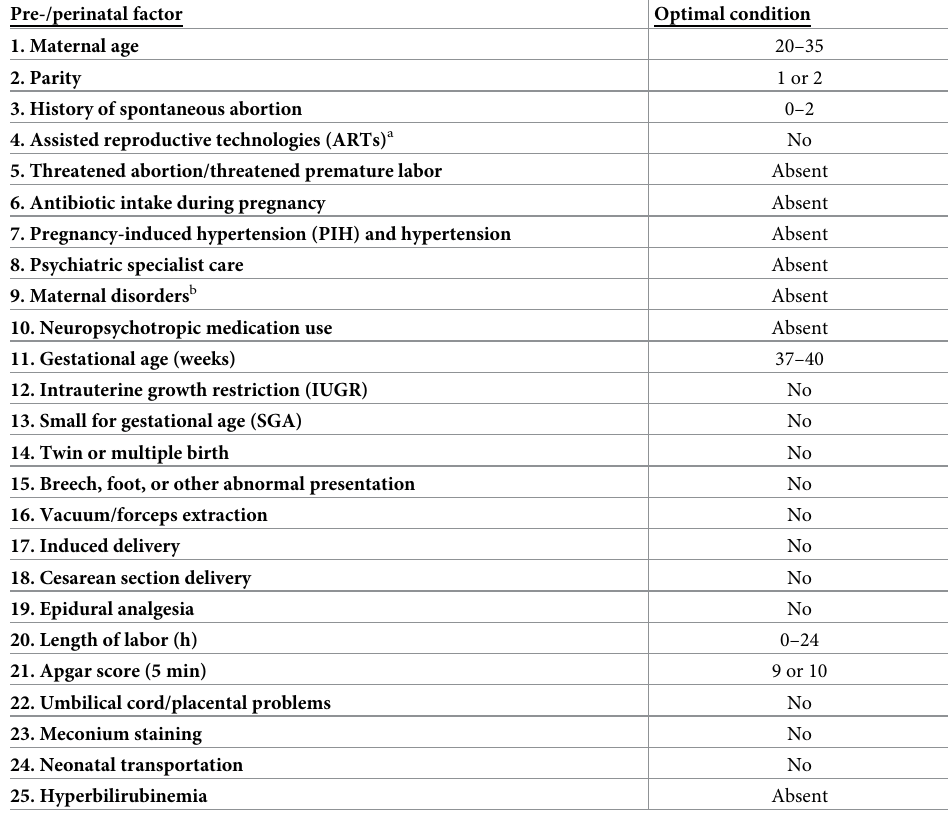
Table 1. Optimality scale: Pre- and perinatal factors and their optimal